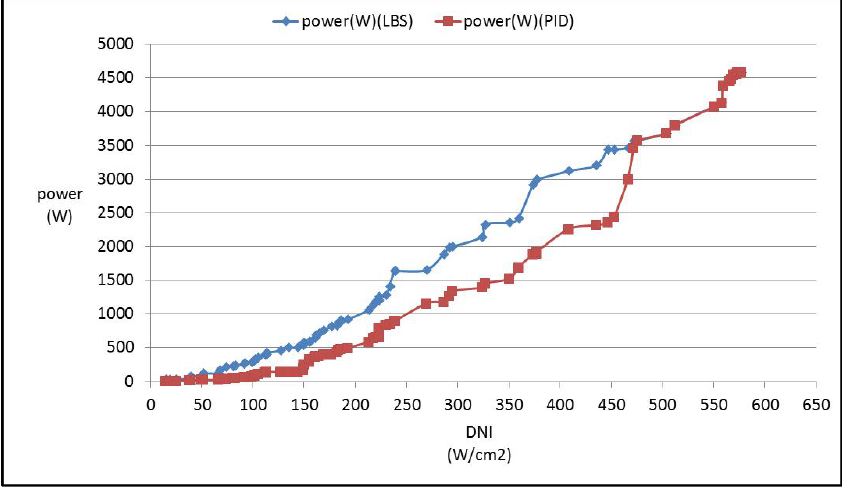
Figure 12. Comparison of power output between LBS control and PID